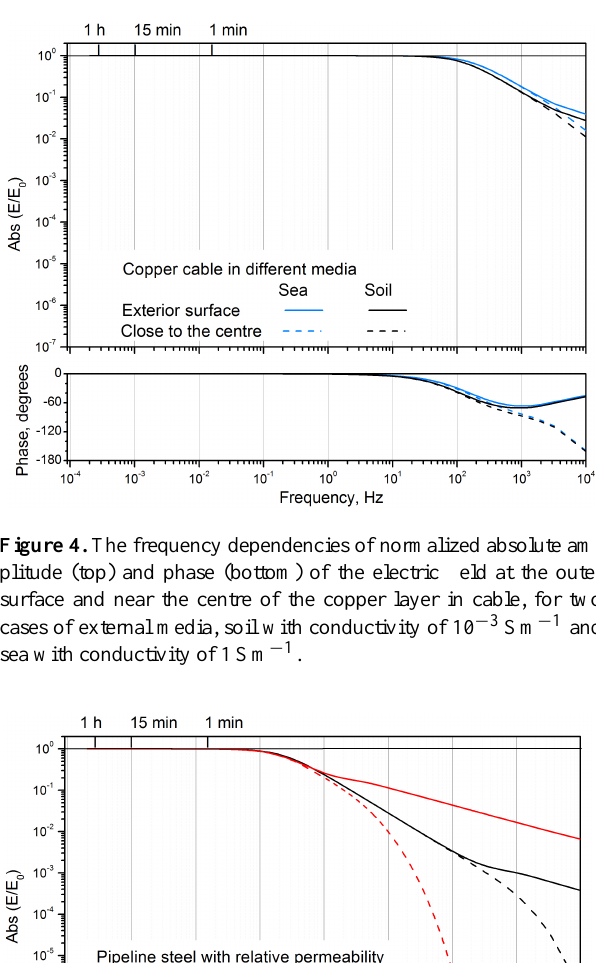
dashed line). As is expected from the boundary